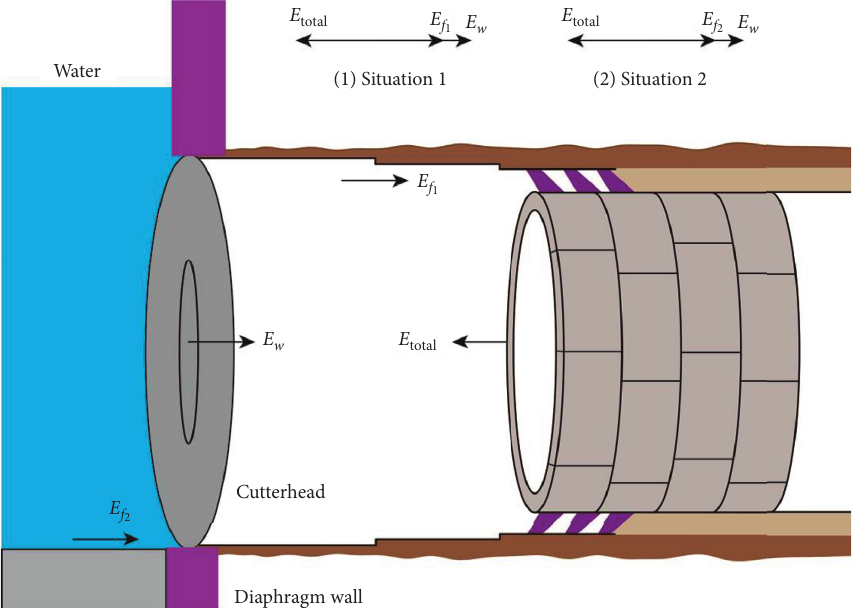
Figure 7: Schematic diagram of shield thrust